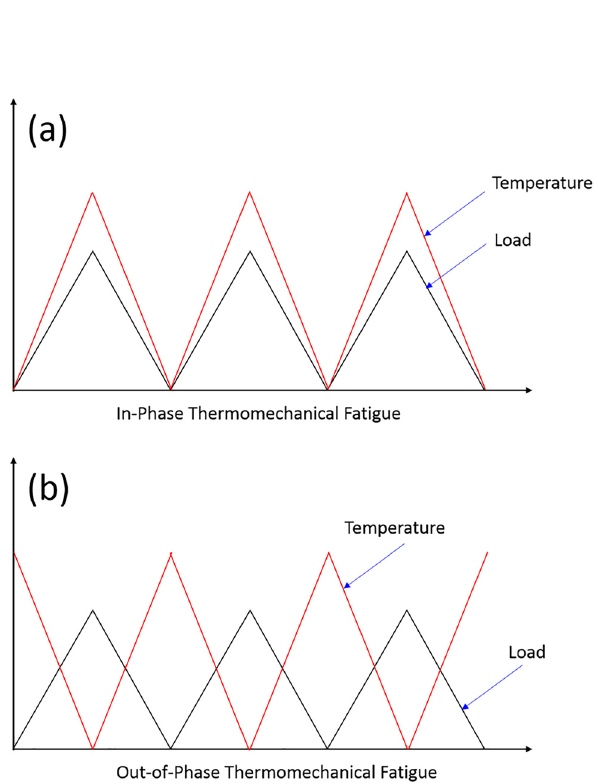
Figure 1: Schematic of TMF loading corresponding to ( a ) IP - TMF loading and ( b ) OP - TMF